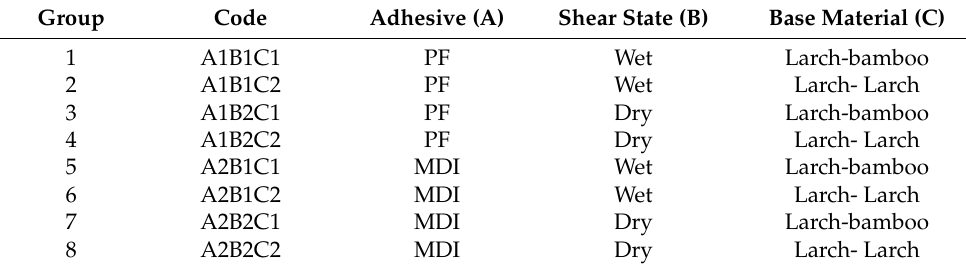
Figure 1. Specimen type and shear damage mode. Table 2. Test combination of